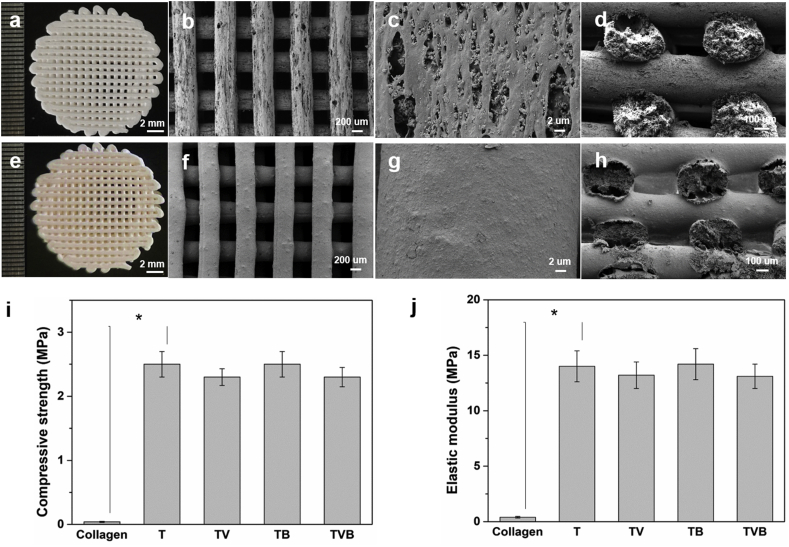
Morphology and mechanical properties of OP/TCP/PLGA and AP/collagen/OP/TCP/PLGA scaffolds. (a) and (e): digital images; (b-d, f-h): SEM micrographs of different scaffolds at different magnification; (i) compressive strengths of scaffolds and controls; (j) elastic modulus of scaffolds and controls. T, TV, TB, TVB refer to TCP/PLGA, AP/collagen/TCP/PLGA, OP/TCP/PLGA, AP/collagen/OP/TCP/PLGA, respectively.